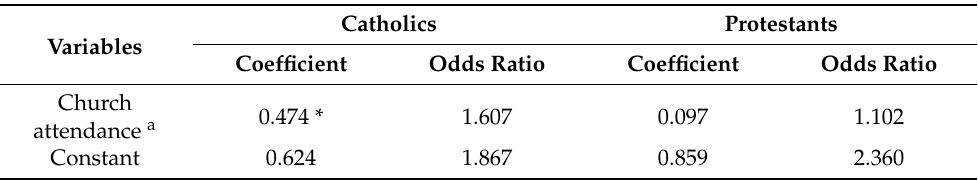
Table 2. Interaction effect of denomination and church attendance on negative attitudes about suicide. Logistic regression results. Catholics Protestants Variables Coefficient Odds Ratio Coefficient Odds Ratio Church 0.474 * 1.607 0.097 1.102 attendance a Constant 0.624 1.867